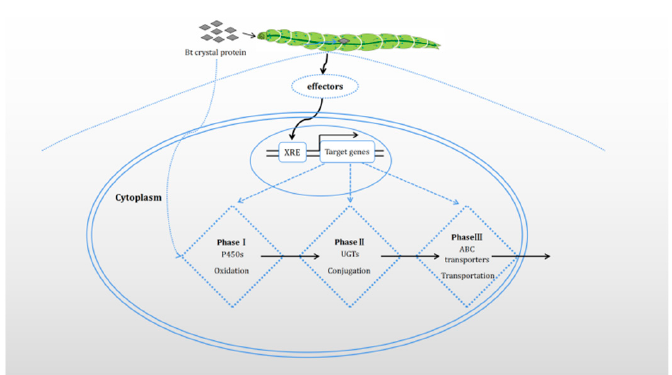
Figure 1. Schematic diagram of the first, second, and third stages of the insecticide metabolism system. Phase I is mainly involved in oxidation by P450s. Phase II forms a conjugate structure with the products of Phase I through UGTs. The ABC transporters in Phase III transfer the metabolites of Phase II from the cell. Insecticide ligands and effectors mediate the regulation of target genes by binding to xenobiotic response element (XRE) at different stages.